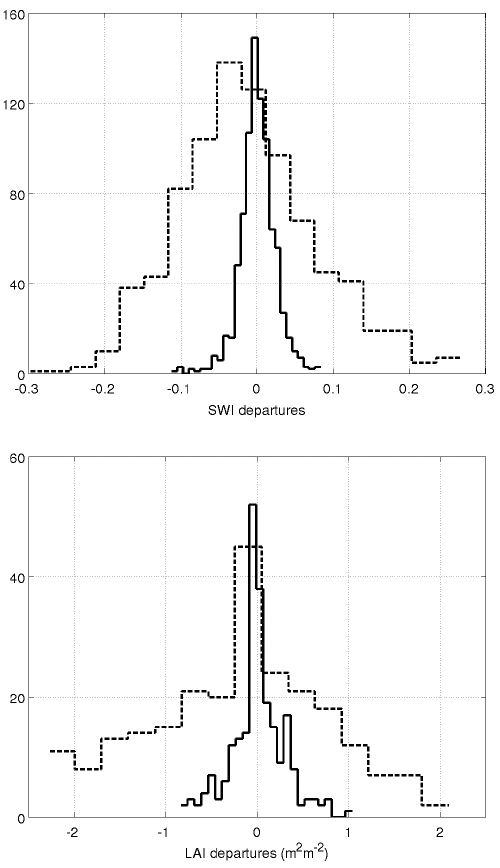
Fig. 7. Innovation (dashed line) and residual (solid line) histograms for (top) SWI and (bottom)